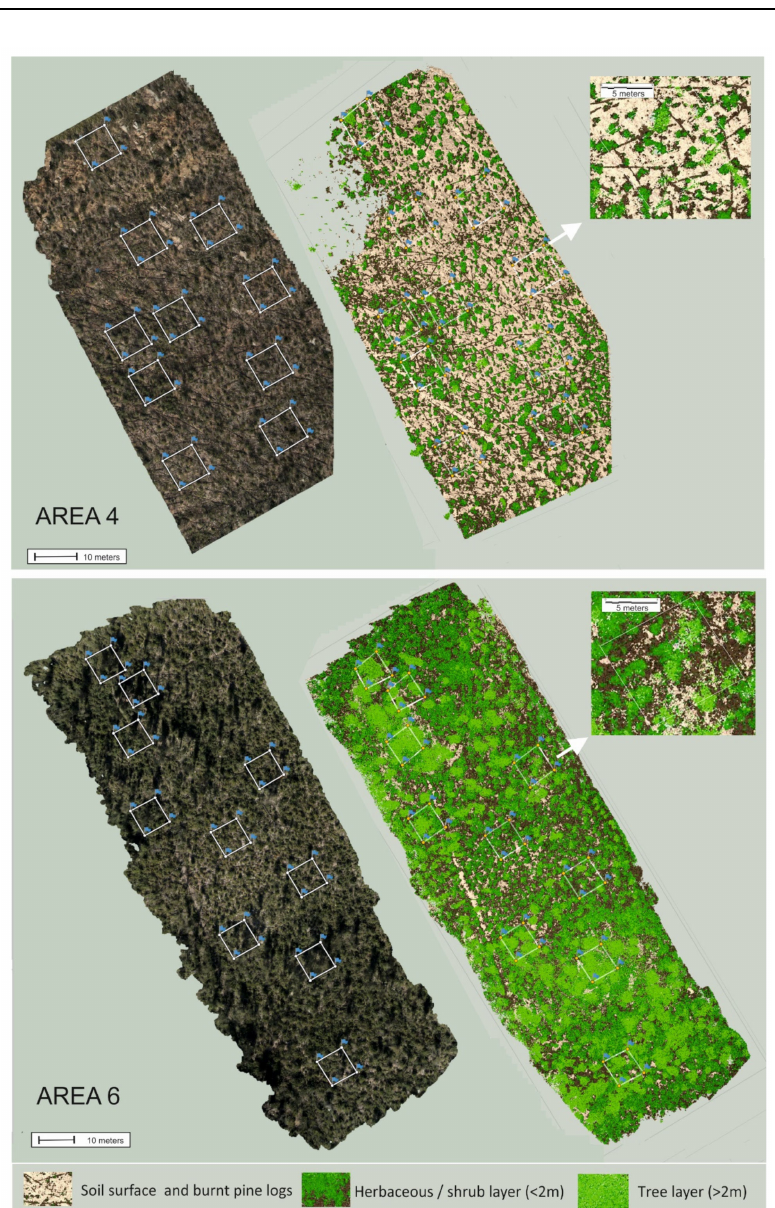
Figure 3. Orthophotomosaic ( left ) and dense cloud point model ( right ) with enlargements of the two areas investigated. White squares are surveys